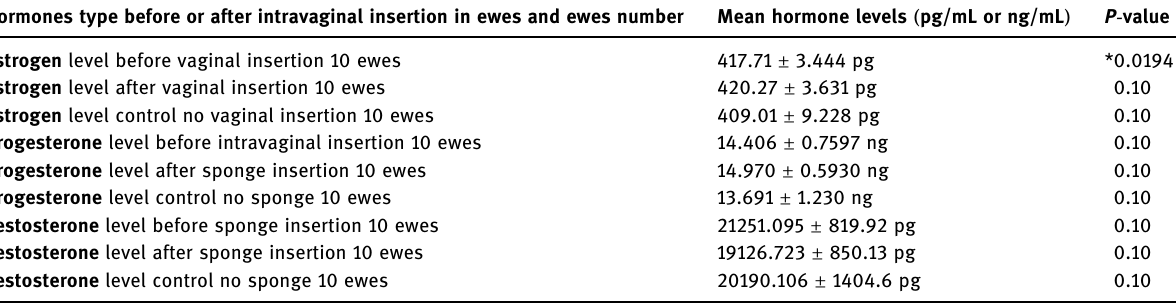
Table 2: Statistical analysis of estrogen, progesterone, and testosterone levels in ewes before or after intra - vaginal insertion compared to the